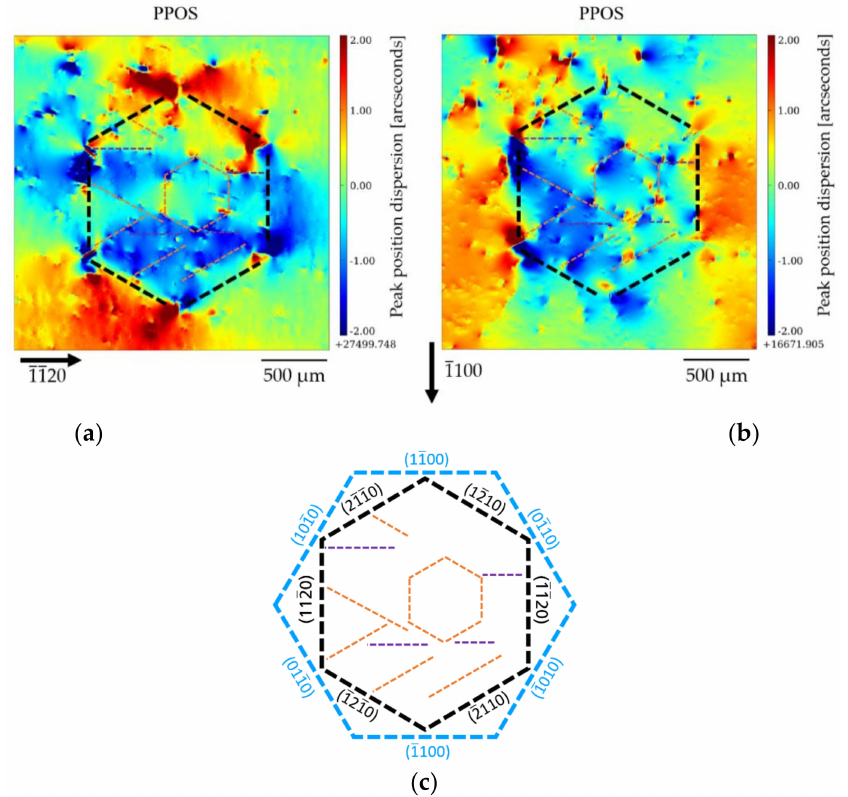
Figure 13. Peak position maps for ( a ) the 1120 reflection and ( b ) the 1100 reflection at 30 keV. The (cid:8) (cid:9) subgrain boundaries along the a -plane 1120 prismatic planes forming the hexagon are indicated as black dashed lines and the subgrains present within the HCD are indicated as orange and violet dashed lines. These last subgrain boundaries mostly go from one TD bundle to the other and can even form smaller honeycombs within the big one. The misorientations among these subgrains are extremely small, in the very few µ radian range. ( c ) Stand-alone subgrain boundaries shown. For better understanding, the orientations of the a -plane facets (black) and m -plane facets (blue) are